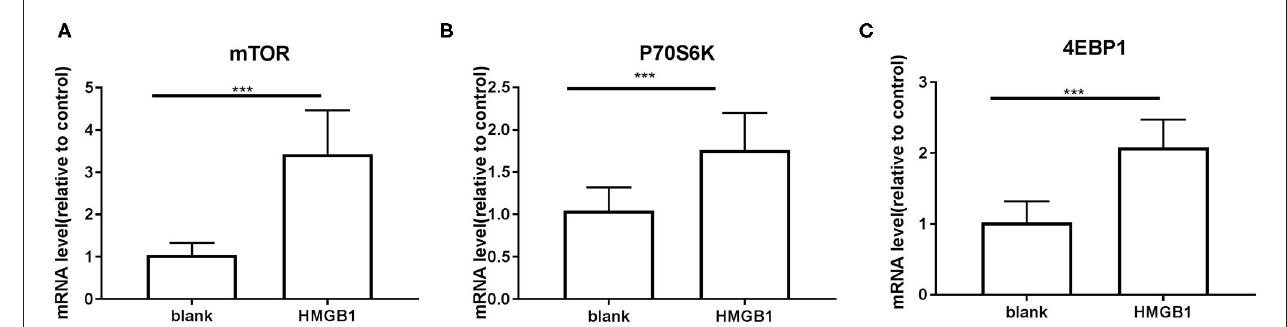
FIGURE 5 | mRNA expression of mTOR and its substrates P70S6K and 4EBP1 on mDCs measured by RT-PCR. Application of the 2 − 11 CT method. The expression of mTOR (A) , P70S6K (B) , and 4EBP1 (C) were up-regulated in mDCs after stimulation with HMGB1. (mTOR: 1.039 ± 0.0651 vs. 3.428 ± 0.2315, t = 9.935, P =